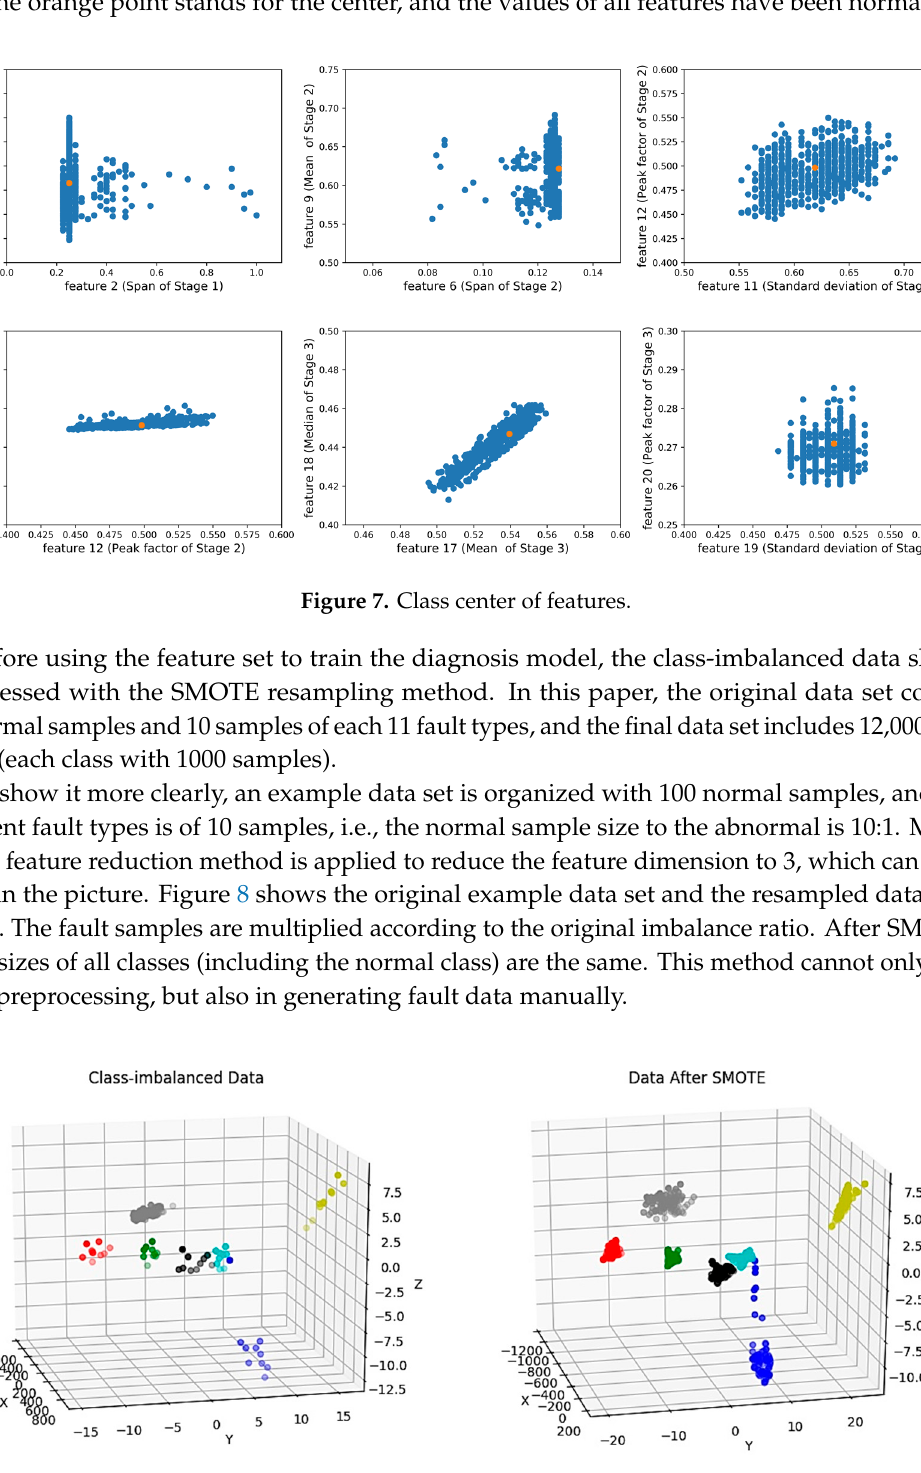
Figure 1. Research framework of this study.